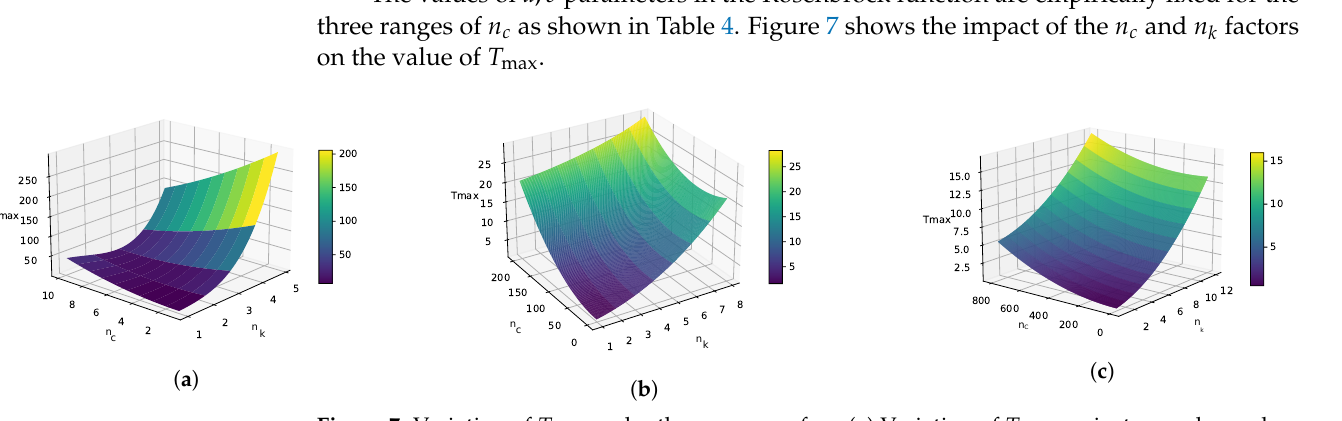
Figure 7. Variation of T max under three ranges of n c . ( a ) Variation of T max against n c and n k , when the n c observed in the neighborhood is between 0 and 10. ( b ) Variation of T max against n k and n c , when the n c observed in the neighborhood is between 10 and 200. ( c ) Variation of T max against n k and n c , when the n c observed in the neighborhood is above 200.